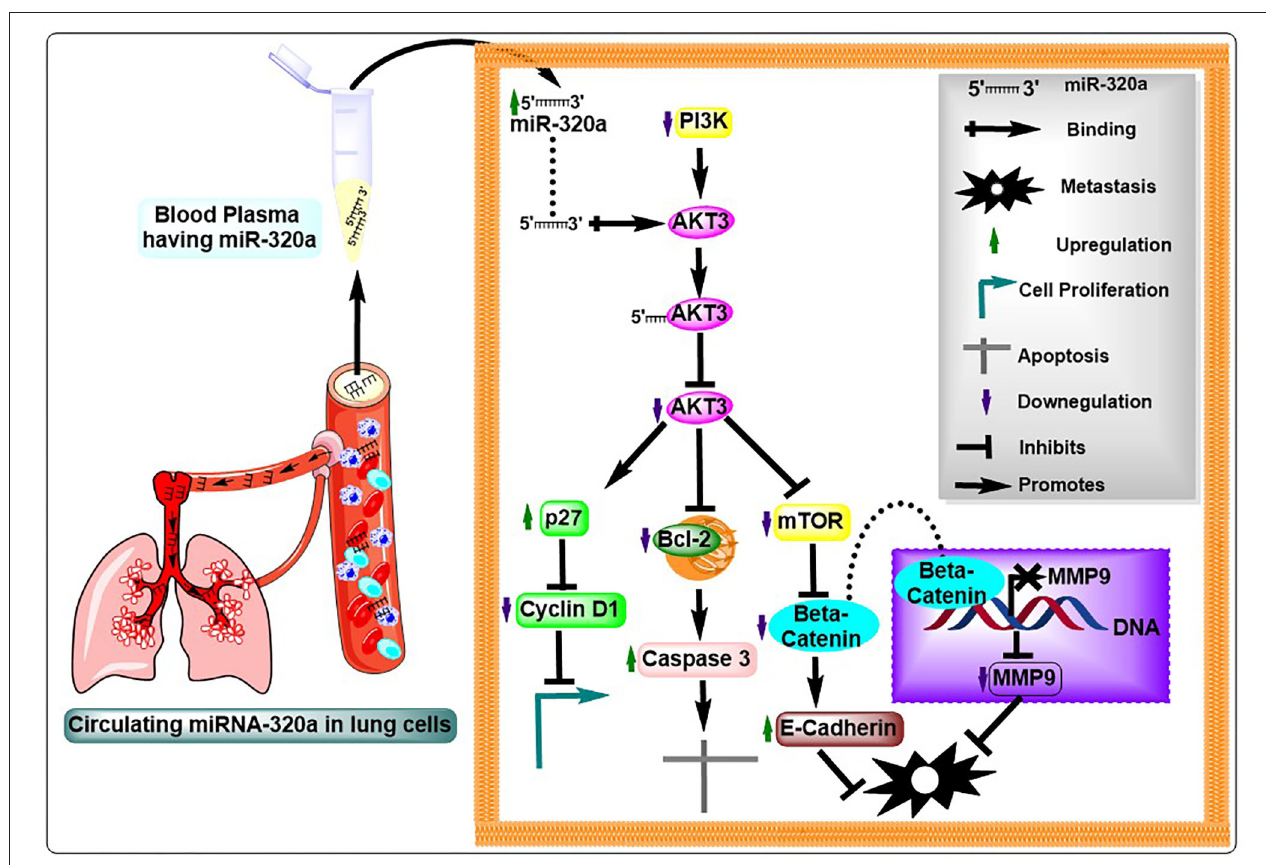
FIGURE 7 | Illustration of the potential mechanistic roles of miR-320a in NSCLC pathogenesis. Circulating miR-320a binding to the 3 ′ UTR of AKT3 results in an increase or decrease in its downstream molecules represented by up and down arrows, respectively, thereby, influencing the AKT3-associated molecules to impact hallmarks of cancer in NSCLC